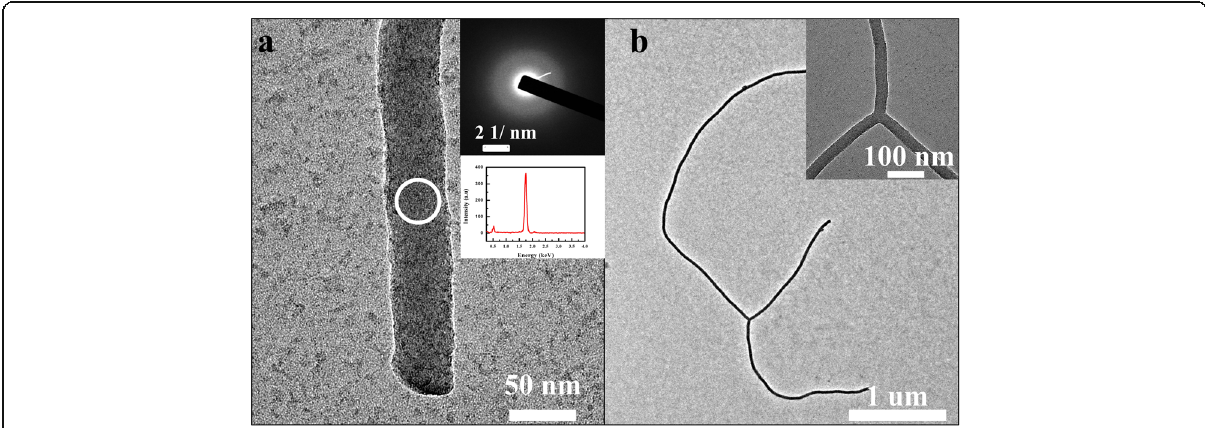
Fig. 4 TEM images of nanowires. a TEM image of the tip part of nanowire. Inset photos were the selected area electron diffraction (SAED) of nanowire and the EDS spectrum respectively. The SAED pattern was obtained from the middle of the wire ( white circle ) in Fig. 4, and the aperture for SAED was 200 nm. b TEM image of nanowire. The inserted image was the detailed photo of nanowire in Fig. 4b